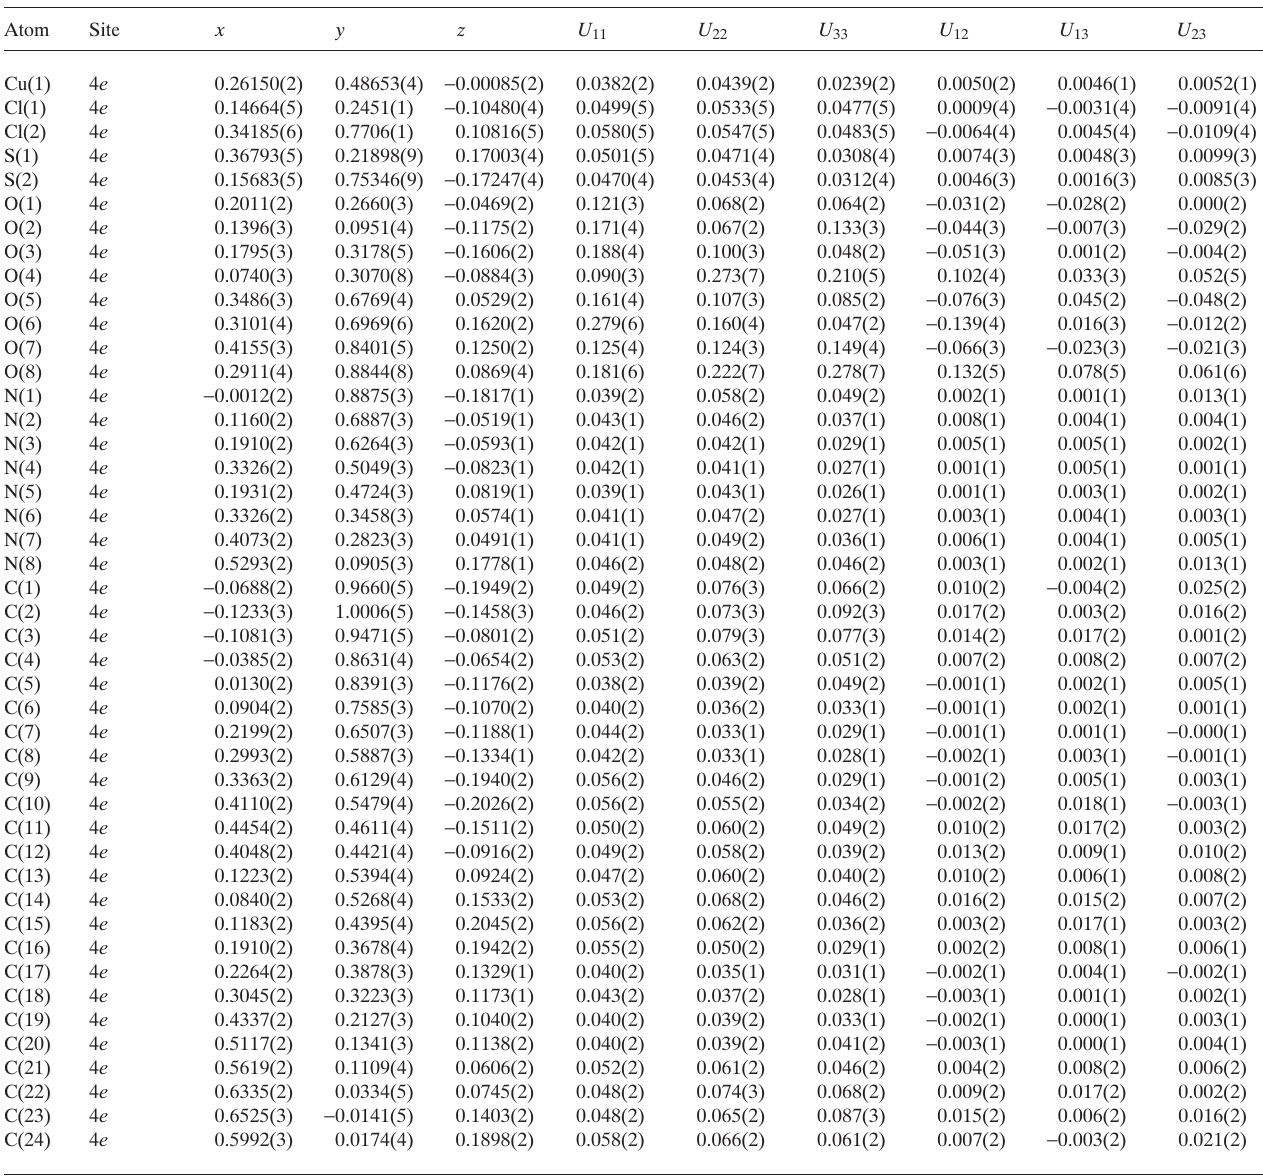
Table 3. Atomic coordinates and displacement parameters (in Å 2 )